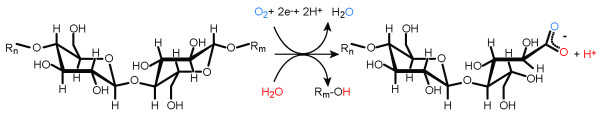
Summary of the oxidative cleavage of cellulose. In the case of cleavage by CelS2, a CBM33, and  Pc GH61D [17] the only oxidized sugars observed are aldonic acids, as indicated in this figure. Other members of the GH61 family seem to generate additional oxidized species, with oxidation at C4 or C6 (see Quinlan et al. [13] and Phillips et al. [16] for further discussion).